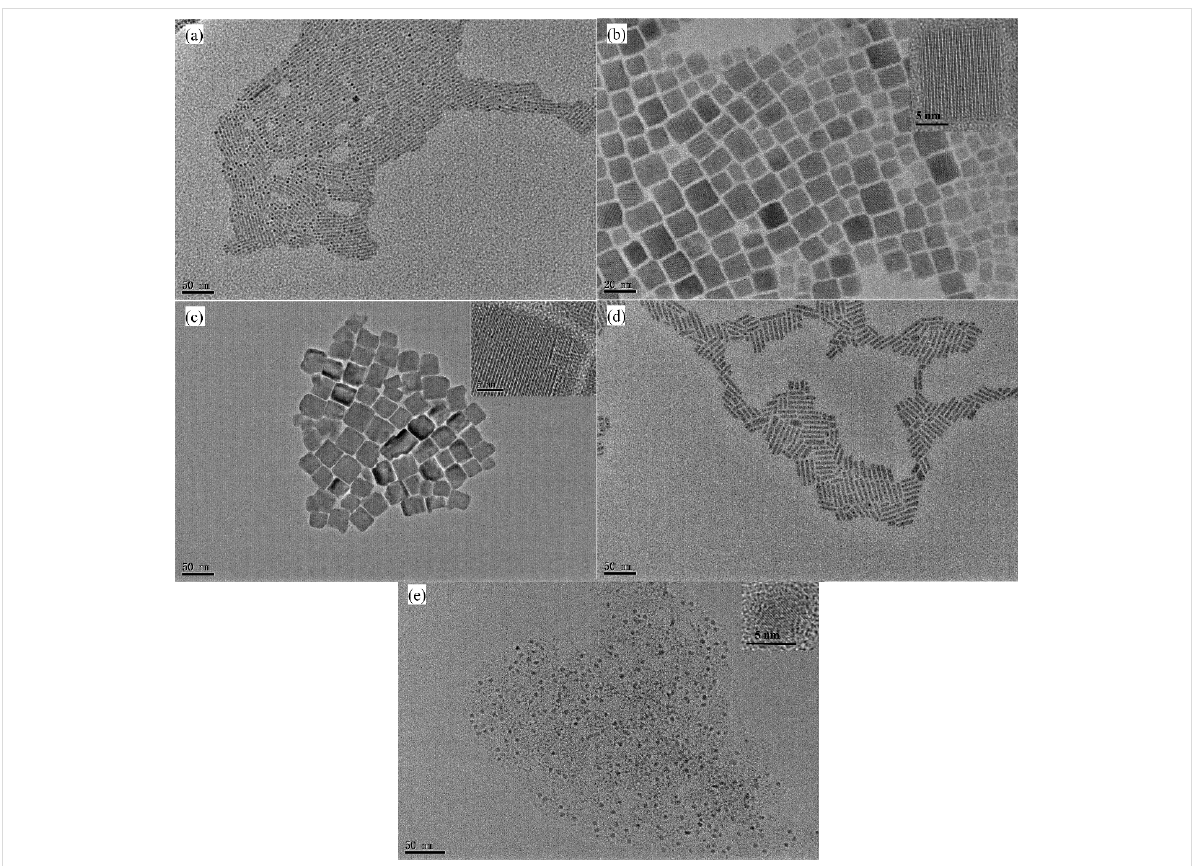
Figure 2: High-resolution transmission electron microscopy images of CsPbX 3 quantum dots of five different colors: (a) blue, (b) green, (c) yellow, (d) orange, and (e)